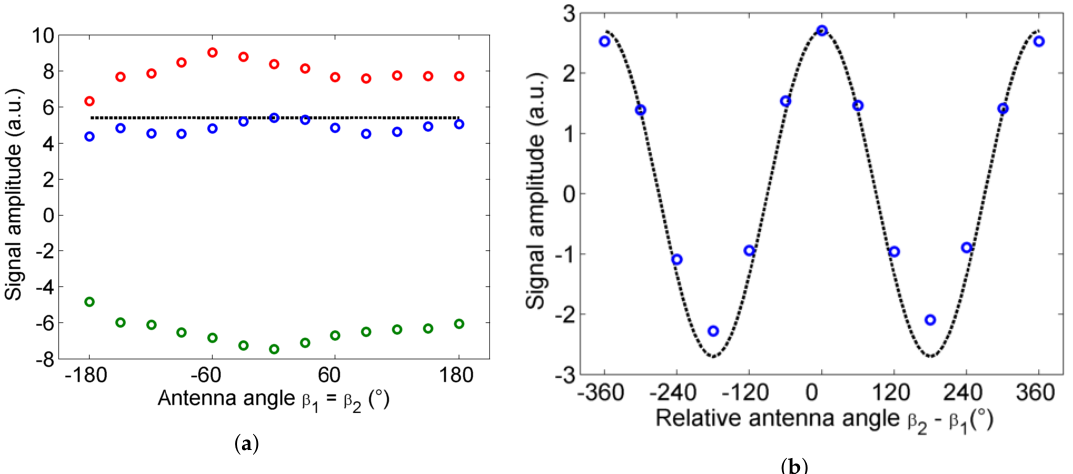
Figure 3. ( a ) Variations in the signal when rotating the PCAs in the same direction: pulse minimum (green), pulse maximum (red) and spectrum amplitude (blue) compared to the model (black). ( b ) Variations in the signal when rotating only the emitter (blue) compared to the model